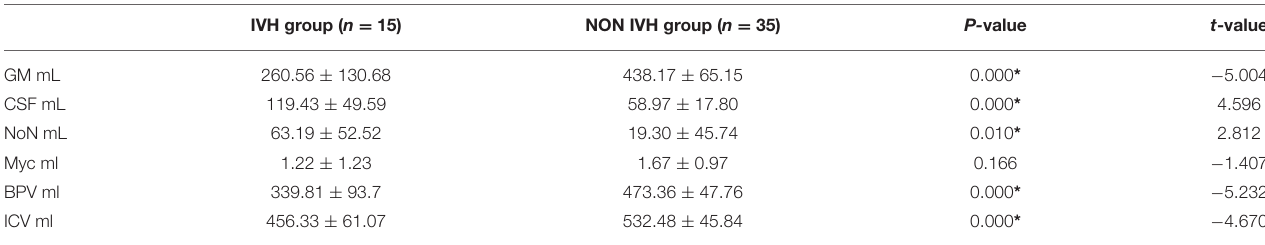
TABLE 3 | Volume comparison between the two